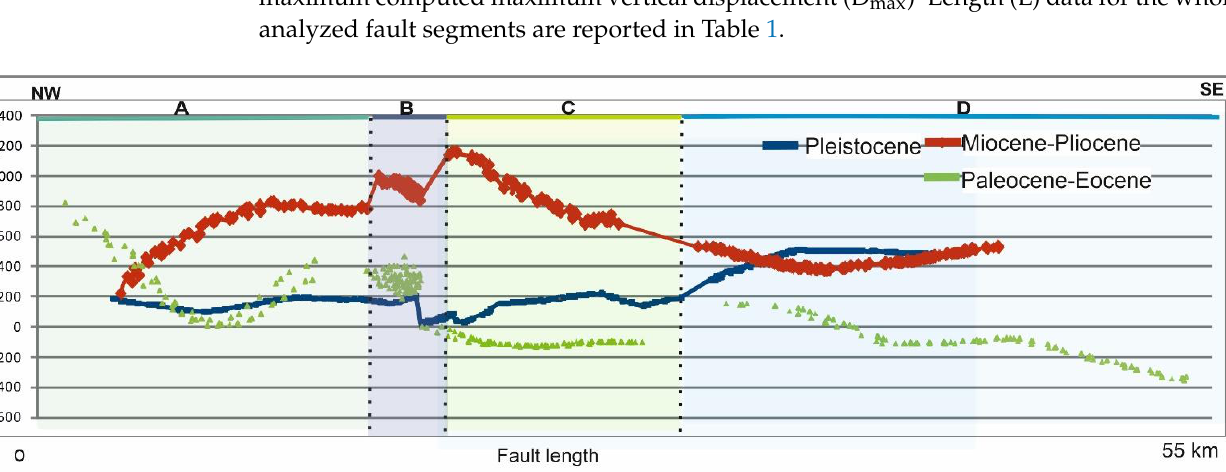
Figure 9. Total Top Pliocene, Top Eocene, and Top Cretaceous throw profiles computed for A to D fault segments.